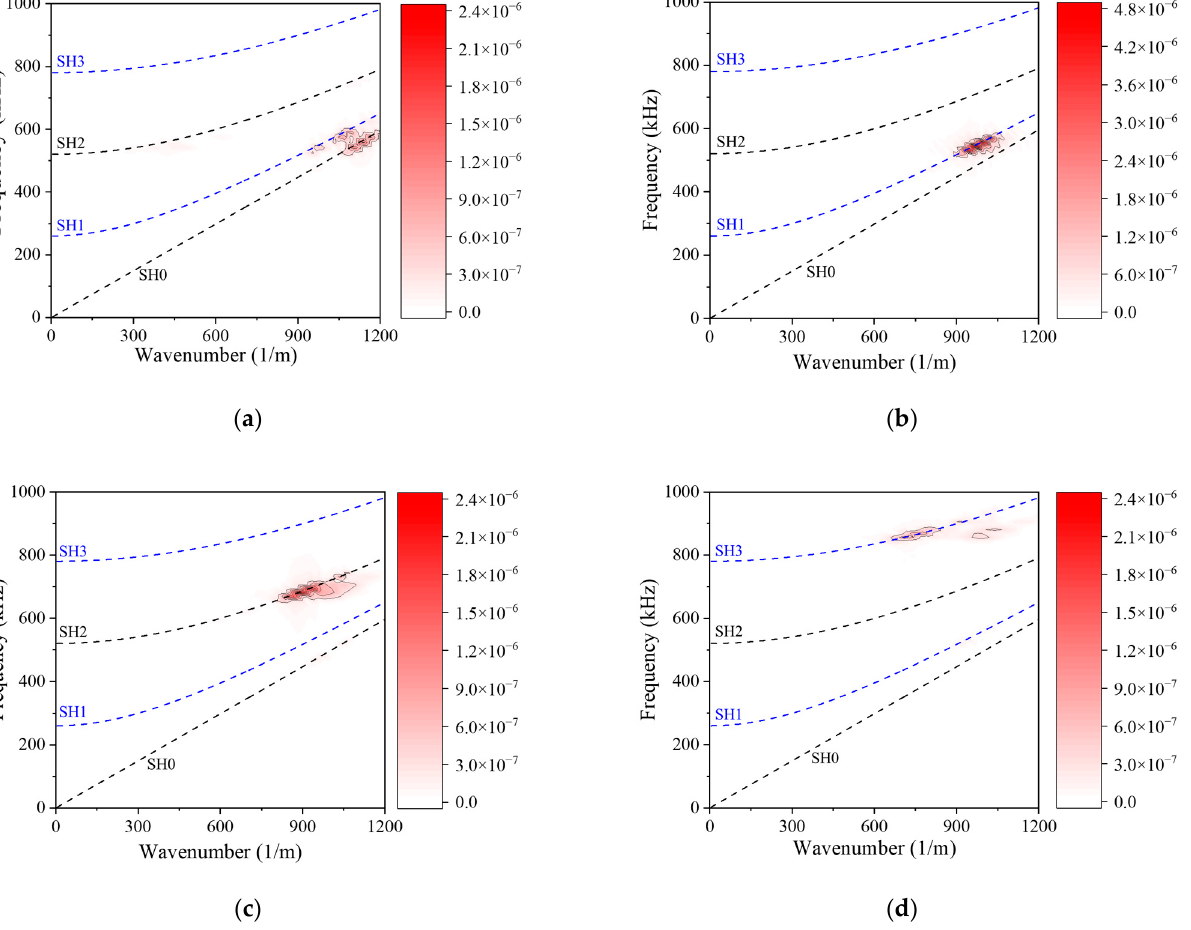
Figure 12. Wavenumber spectra acquired from wave fields in Figure 11: ( a ) Single-sided MST at 563 kHz, ( b ) double-sided MST at 563 kHz, ( c ) double-sided MST at 719 kHz, ( d ) double-sided MST at 922 kHz. The intensity scale in ( b ) is different from the others.